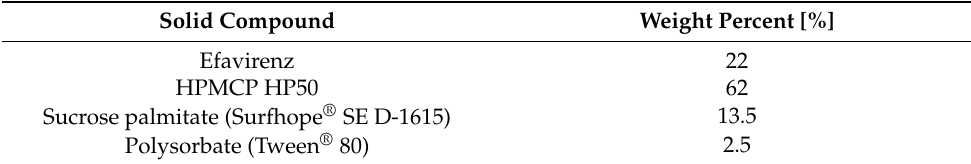
Table A1. ASD composition.